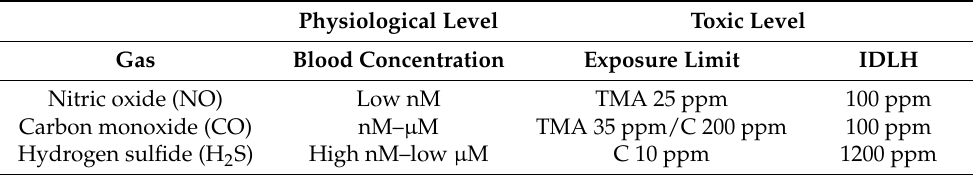
Table 1. Physiological and toxic levels of NO, CO, and H 2